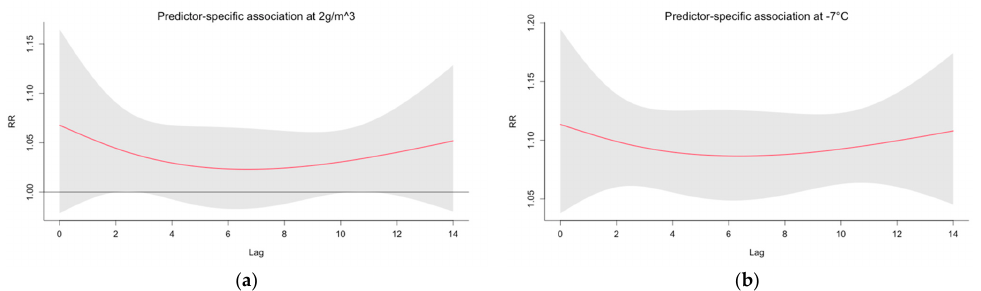
Figure 6. Relative risks (RR) of COVID-19 at ( a ) 2 g/m 3 and ( b ) − 7 °C over a 14-day lag, for the time period 1 August 2020 until 31 May 2021 at the Helsinki-Uusimaa Hospital district . The predictor- specific associations were calculated with Model 2 with three fixed knots for each predictor variable. The grey area illustrates the 95%-CI (confidence interval) of the modelled relationship. As a sensitivity analysis, we show additional modelled relationships (see Supple- mentary Material), and show that the different model versions as well as longer study period including spring 2020 produced similar generic patterns, i.e., increased COVID-19 risks at low values of AH or T, and decreased risks at higher values of AH or T.